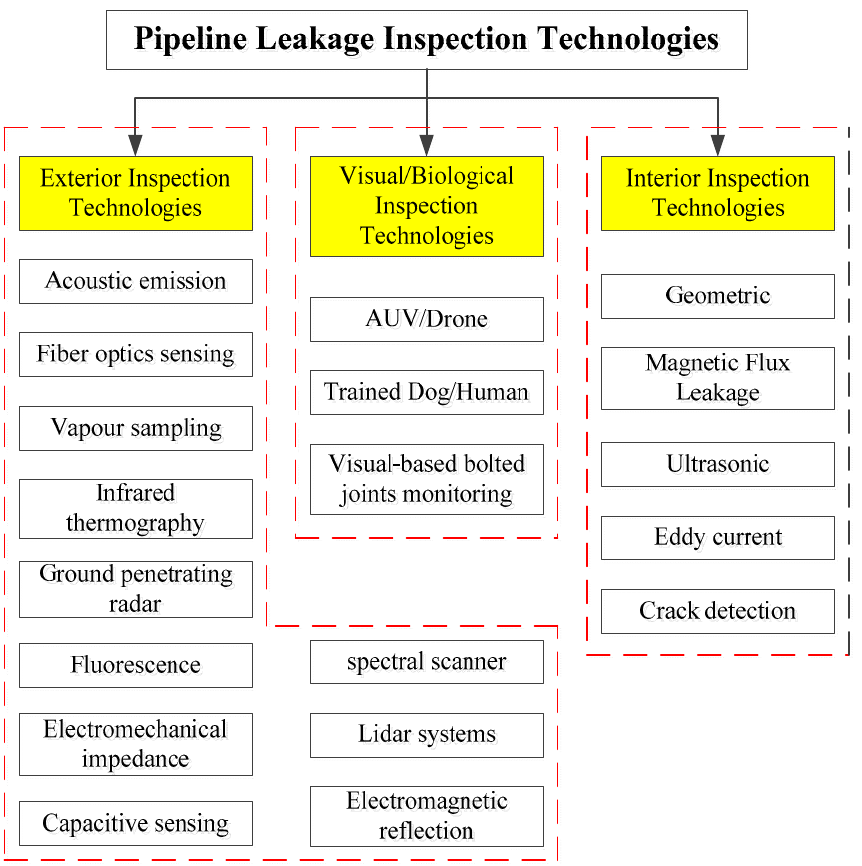
Figure 2. Schematic diagram of different pipeline leakage inspection technologies. Table 2. Summary of interior pipeline leakage detection technologies.